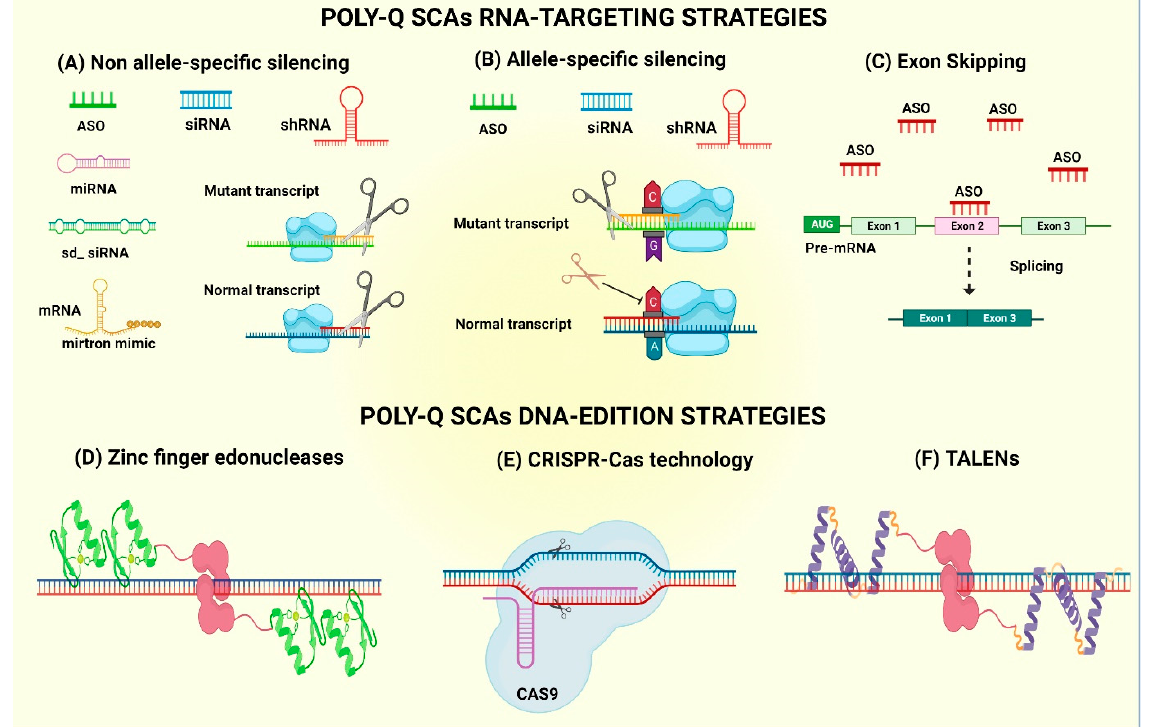
Figure 3. Molecular strategies for polyQ SCA therapy. ( A ) Non-allele-specific silencing of mutant genes by using antisense oligonucleotides (ASOs), small interfering RNAs (siRNAs), short hairpin RNAs (shRNAs), microRNAs (miRNAs), sd-siRNA or mirtrons. ( B ) Allele-specific silencing using ASOs or shRNAs that target a single-nucleotide polymorphism (SNP) linked specifically to the mutant allele, in order to induce its cleavage while maintaining intact WT mRNA expression. ( C ) Exon skipping on primary mutant RNAs by splicing blockage with ASOs. ( D ) Gene editing using zinc-finger endonucleases. ( E ) CRISPR-Cas9 technology. ( F ) Gene editing by TALENs.